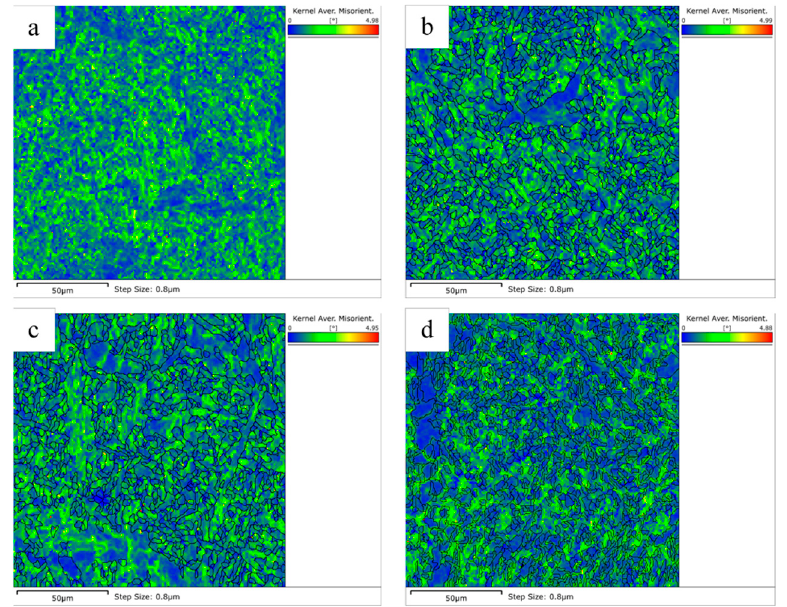
Figure 15. Kernel average misorientation in air and water environments. ( a ) In air and ∆ K , is 45 MPa·m 1/2 ; ( b ) in air and ∆ K , is 60 MPa·m 1/2 ; ( c ) in water and ∆ K , is 45 MPa·m 1/2 ; ( d ) in water and ∆ K , is 60 MPa·m 1/2 .